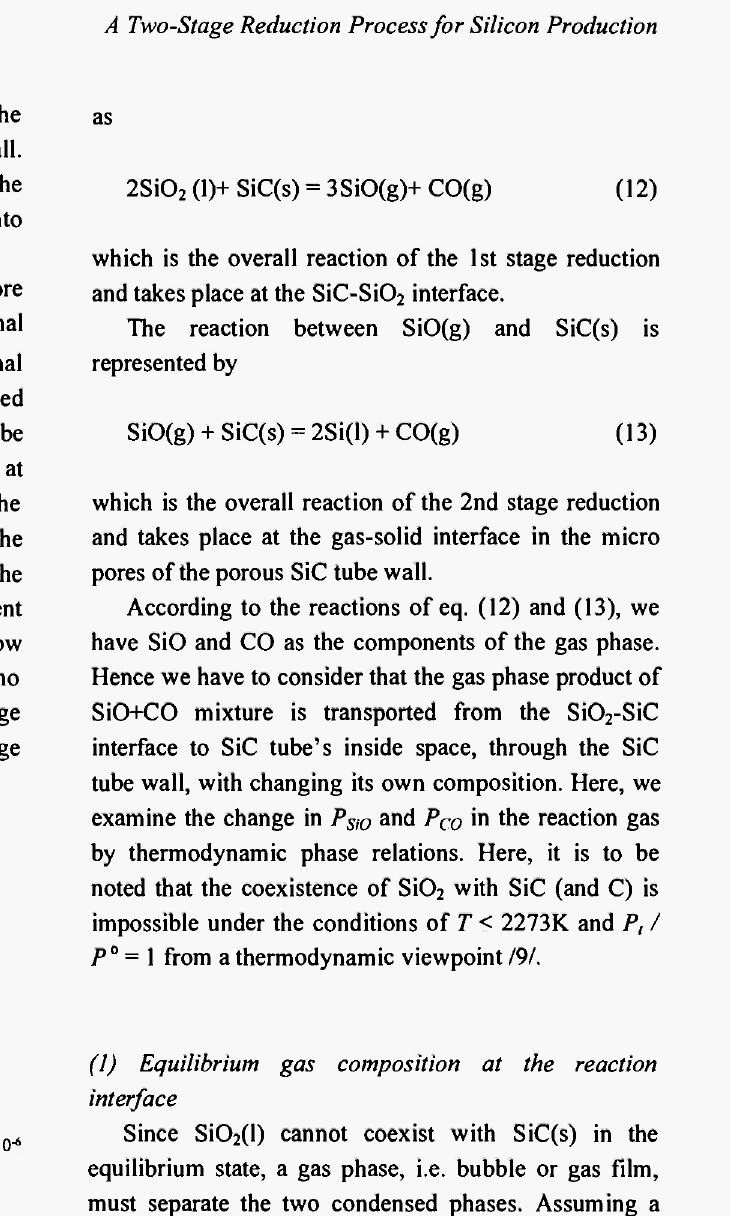
Fig. 7: Effect of hydrogen flow rate on the amount of Si formed by the